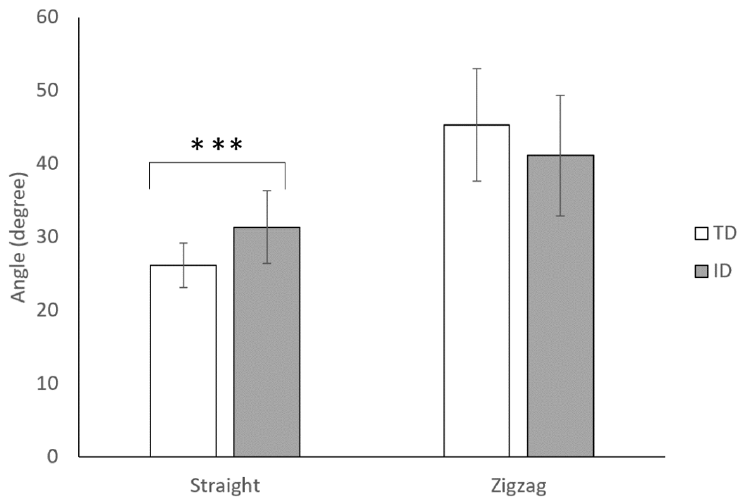
Figure 6. Comparisons of trunk-forward angles of adolescents with TD and ID during the dribbling tests. *** p <0.001.